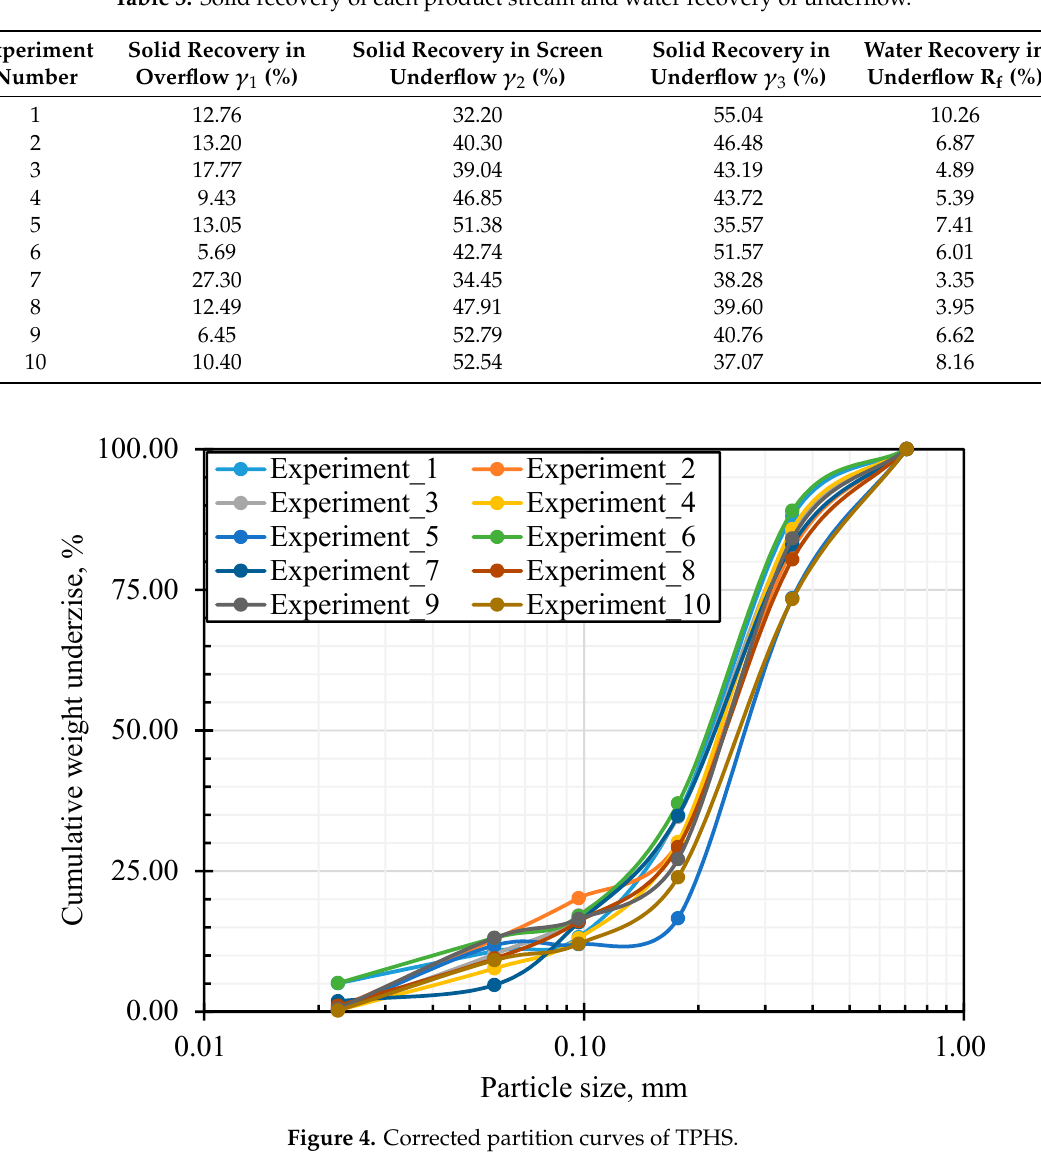
Table 3. Solid recovery of each product stream and water recovery of underflow.